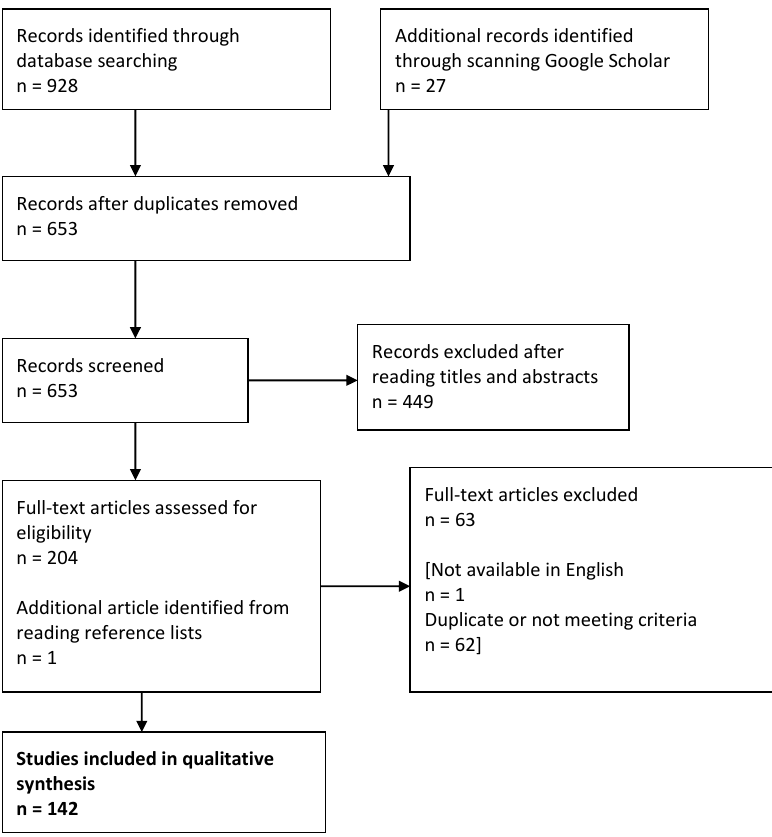
Figure 1. Process of refining results from the systematic review.